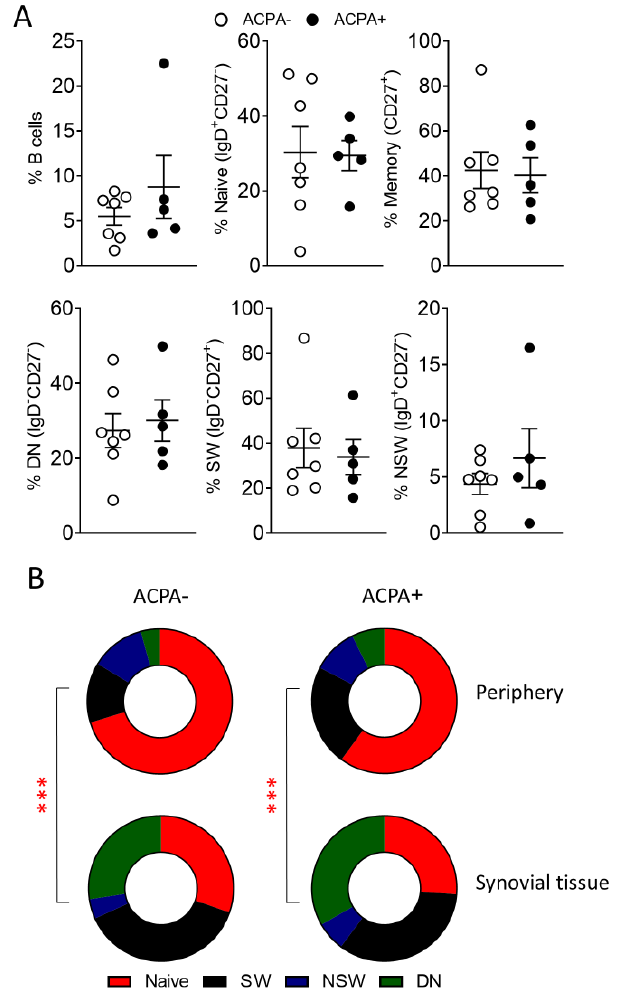
Figure 2. Synovial tissue B cells of ACPA− and ACPA+ RA patients. ( A ) Frequency of the indicated synovial tissue B cell subpopulations of ACPA− (n = 7) and ACPA+ (n = 5) RA patients. ( B ) Comparison of peripheral blood and synovial tissue B cell subpopulation frequency for ACPA− and ACPA+ RA patients, average p value range when comparing B cell subpopulations for the indicated groups is shown. Data are presented as mean ± SEM, symbols represent individual samples. Statistical analysis was performed by using two-tailed Mann-Whitney test, p < 0.001